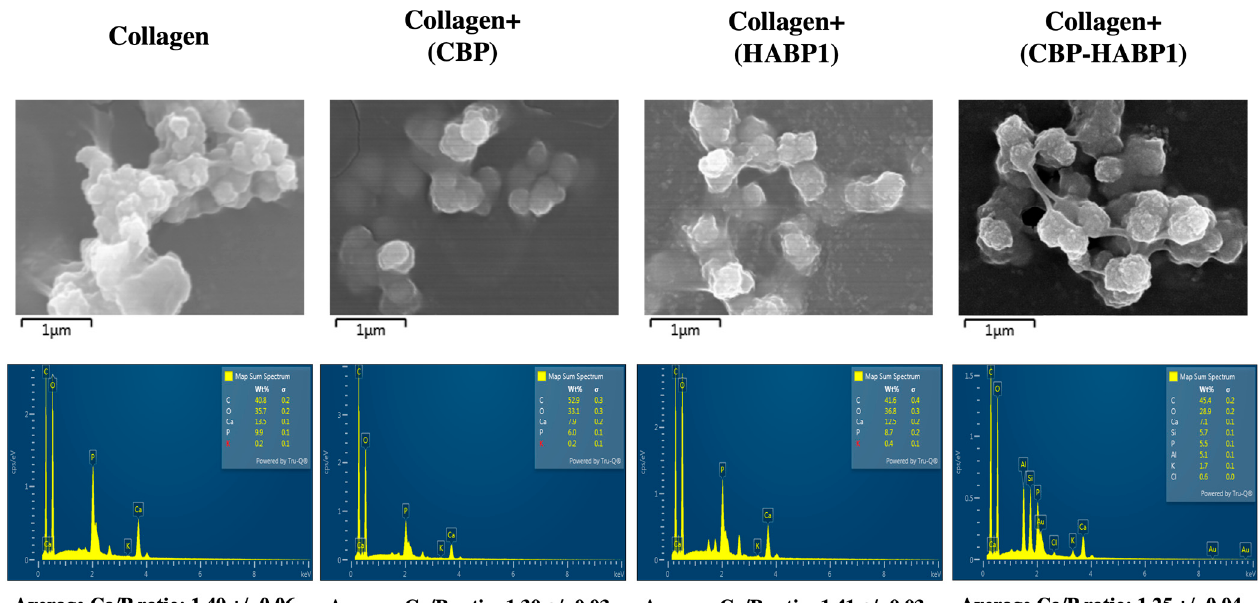
Figure 10. Mineral deposition on peptide-incorporated collagen samples via SEM images with corresponding EDS spectra. Ca/P averages displayed below EDS spectra, calculated across minimum three unique areas per peptide-functionalized collagen sample. Scale bar is under each image, 1 mm.